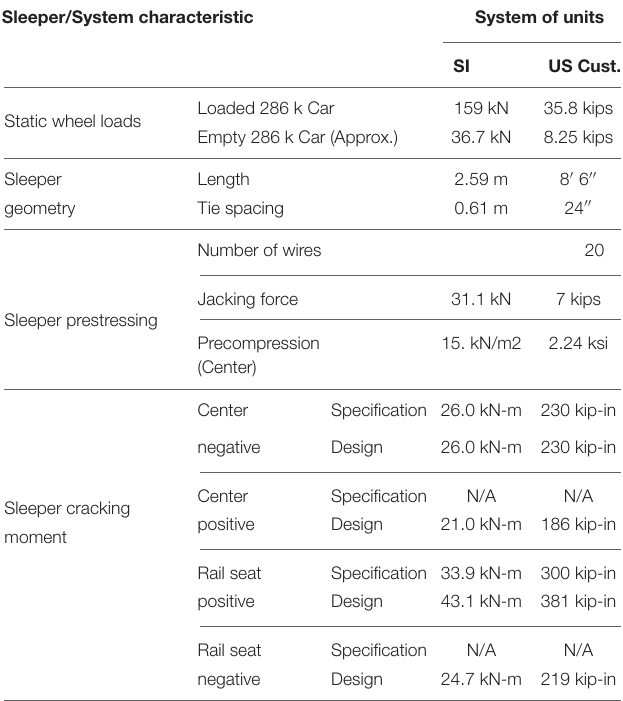
TABLE 1 | Characteristics of HAL freight railroad loading conditions and sleeper structural geometric properties for the locations considered in this study. Sleeper/System characteristic